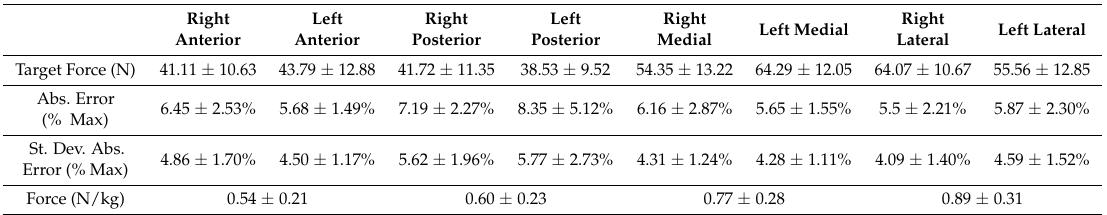
Table 1. Error calculations (mean ± standard deviation) for both the right and left limb in all directions tested during the force control task for healthy uninjured participants.